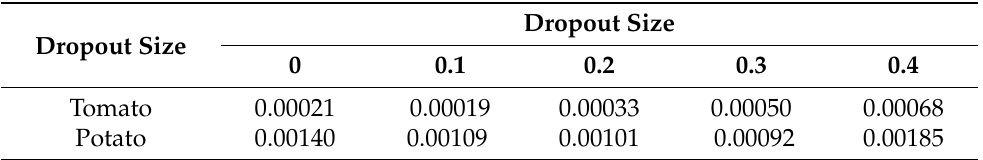
Figure 4. Left side shows the normal neural network and the right side shows the network with dropout. Table 1. Validation lost under different dropout